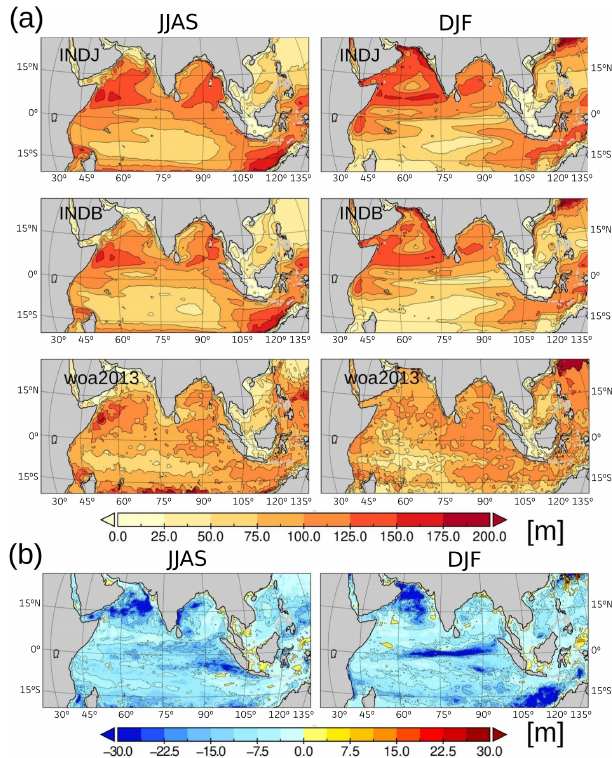
Figure 13. (a) Comparison of simulated thermocline depth with thermocline depth derived from WOA 2013 data sets for JJAS (left) and DJF (right). (b) The difference in thermocline depth between the two runs (INDB–INDJ) for JJAS (left) and DJF